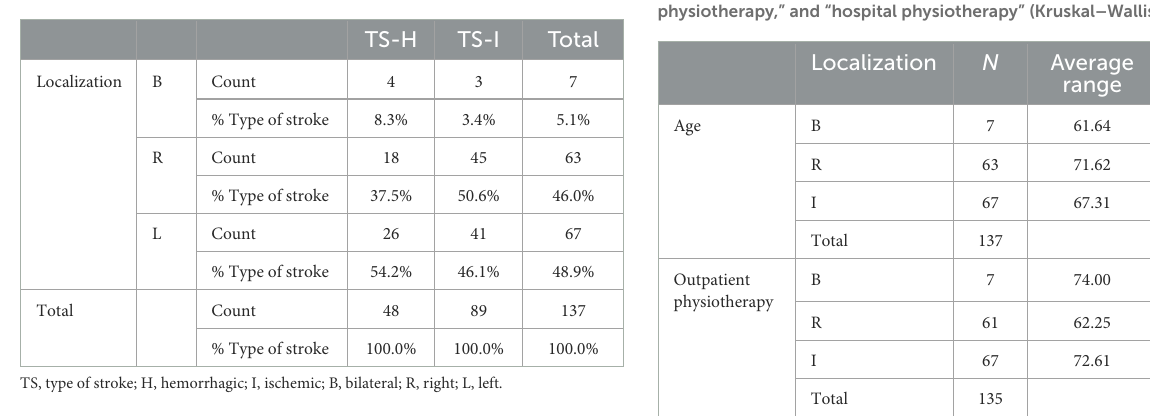
TABLE 2 Contingency table: Localization type of stroke.